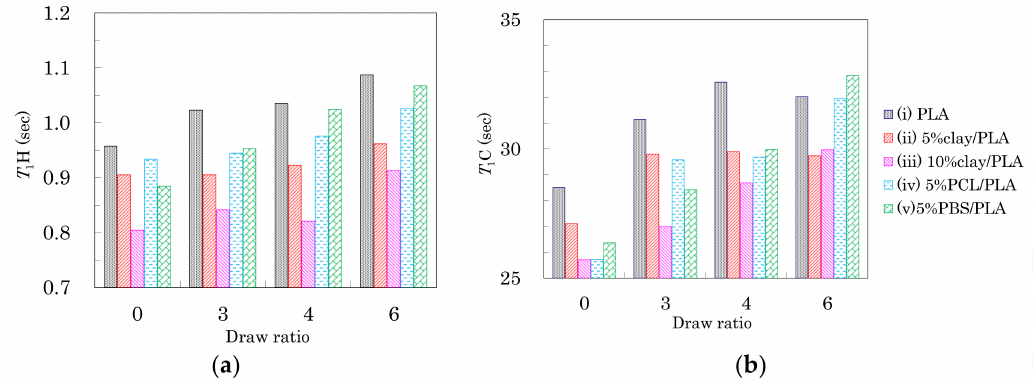
Figure 6. T 1 H values ( a ) and T 1 C values ( b ) of the CH signal from PLA fibers versus fiber draw